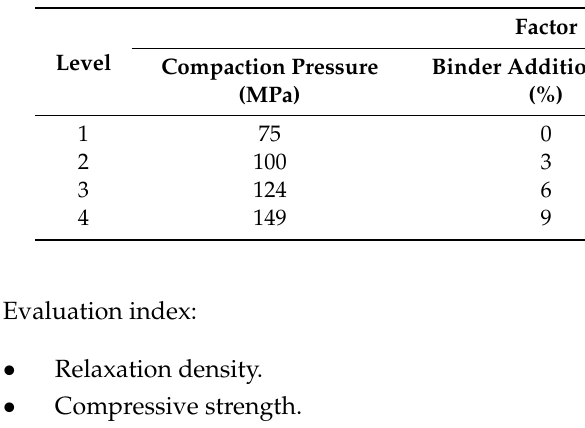
Table 1. Orthogonal test table of three factors mixed